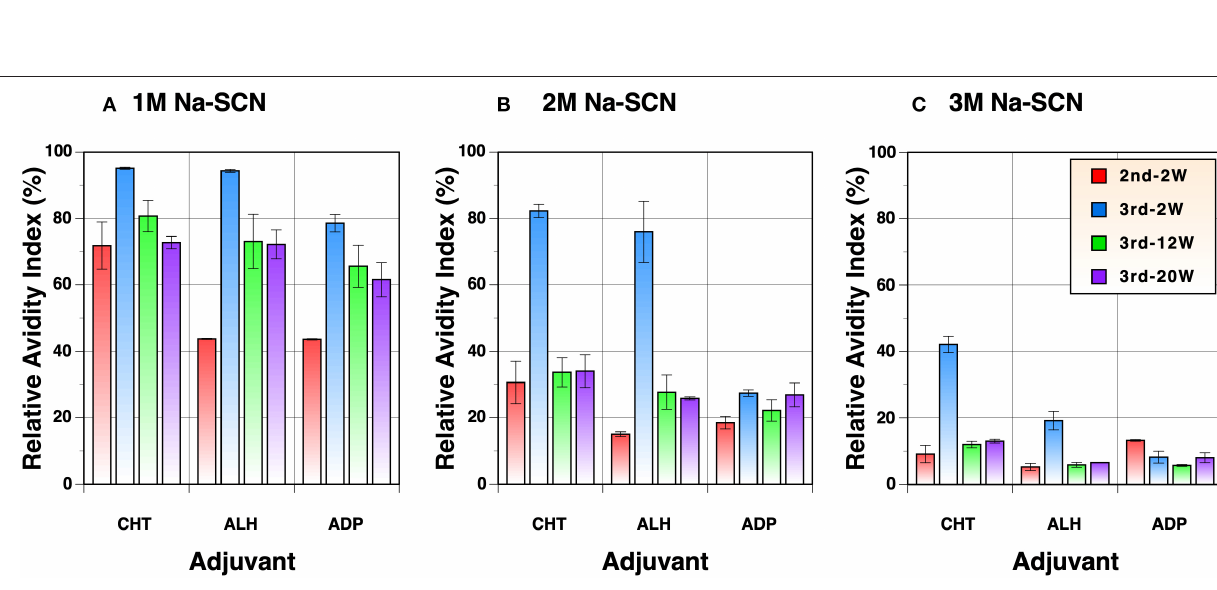
Frontiers in Immunology |